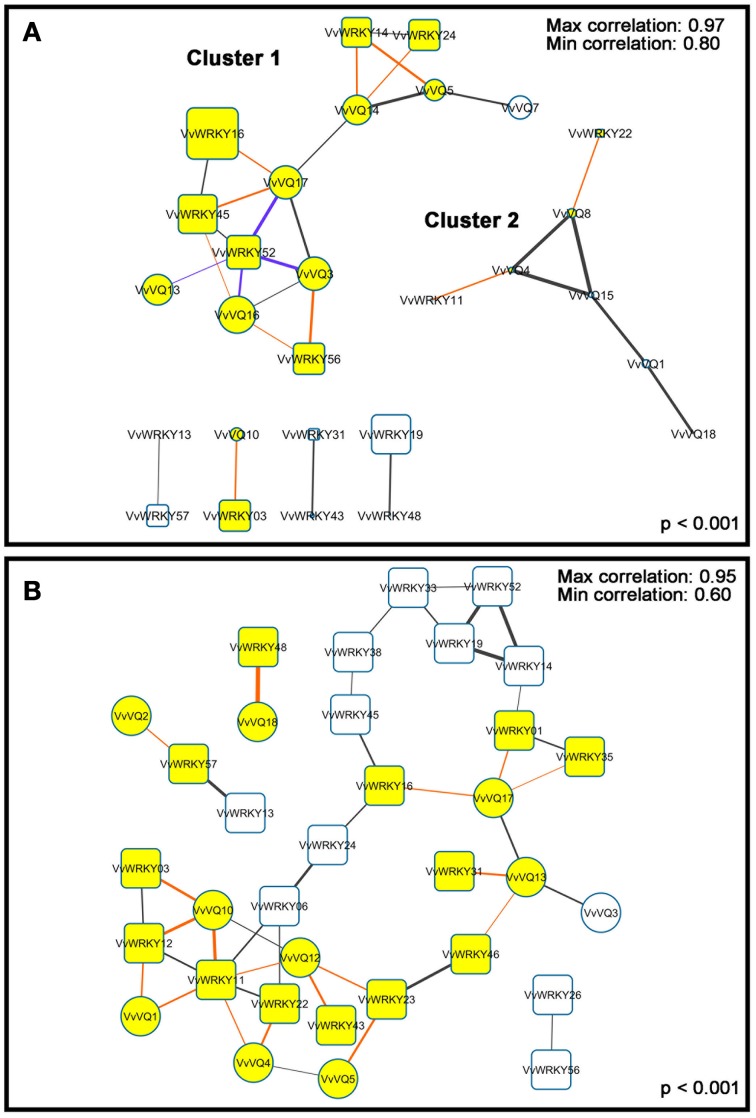
Co-expression network of grapevine VQ motif-containing genes and WRKY genes according to a p < 0.001. Thicker lines indicate more correlated genes. Blue and red lines, indicate negative and positive co-expression between a VQ motif-containing gene and a WRKY gene. VQ-WRKY correlated genes are showed in yellow. (A) Correlation network of PHW berries (Fasoli et al., 2012). The correlation coefficients of co-expression is between 0.8 and 0.97. Larger squares indicate more expressed genes. (B) Correlation network of all tissues described by Fasoli et al. (2012) except for PHW berries. The correlation coefficients of co-expression is between 0.6 and 0.95.